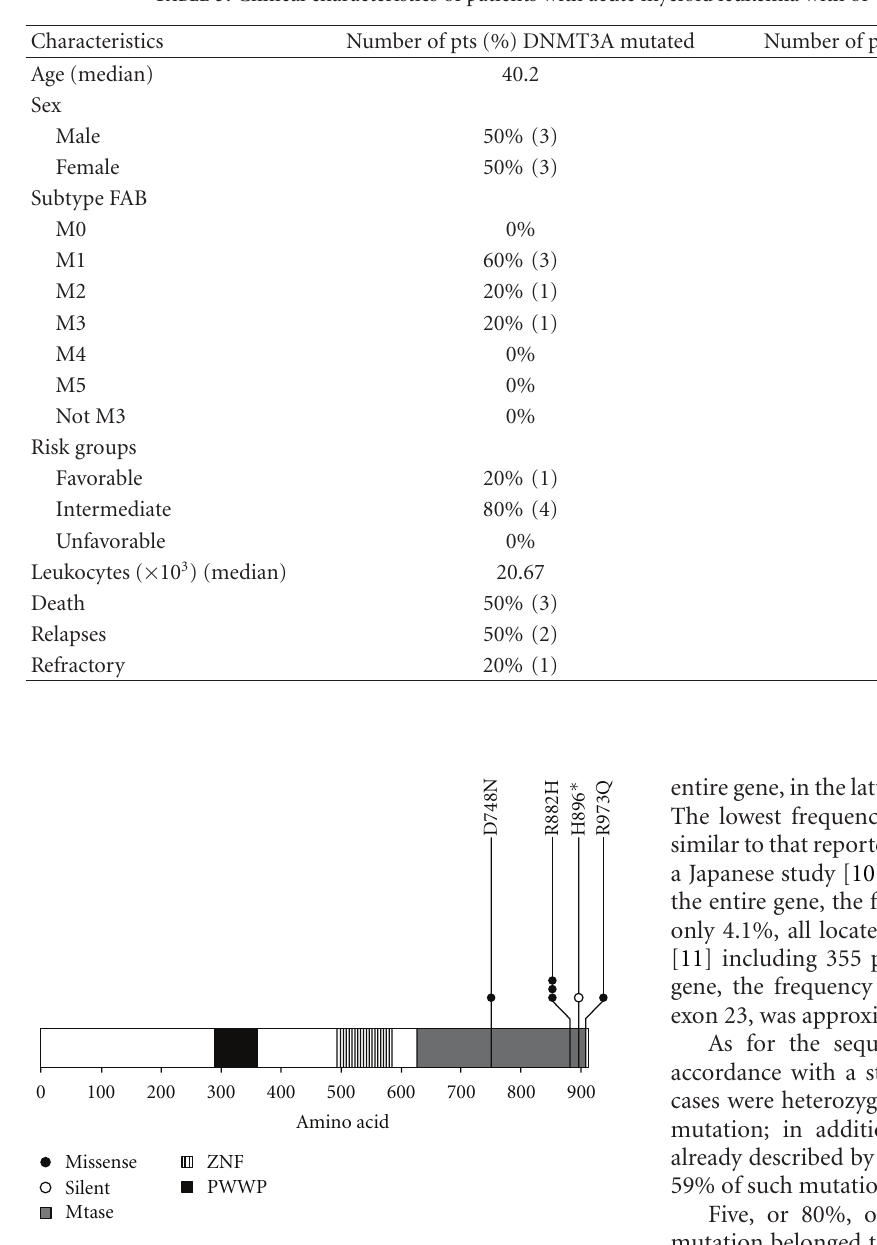
Figure 3: Location and classification of gene mutations found in gene DNMT3A . Representation of the DNMT3A gene and its domains: methyltransferase (MTase), zinc-finger (ZNF), and con- served proline-tryptophan-tryptophan-proline